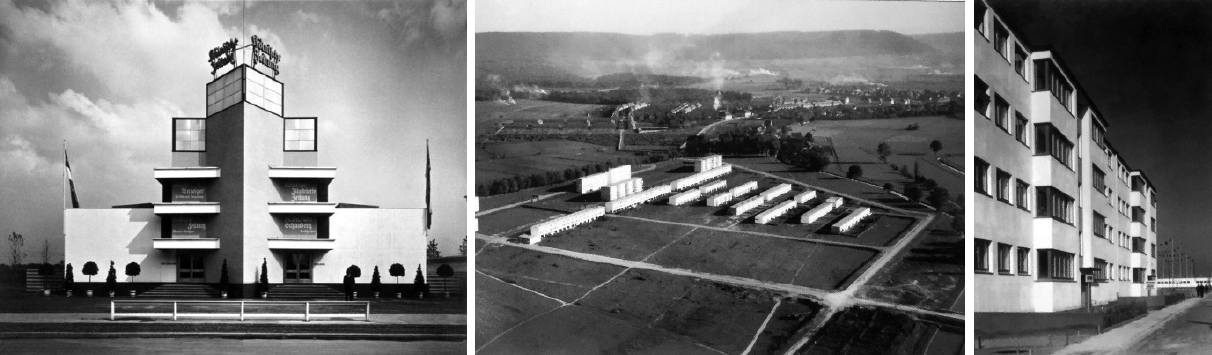
Figure 2. From left to right: W. Riphahn and C. M. Grod, Pavilion for the Kölnische Zeitung at the Pressa –International Press Exhibition Cologne, 1928 (Mantz, 1928); W. Riphahn and C. M. Grod, Dammerstock-Siedlung, aerial view from northwest, Karlsruhe, 1931 (Sträle, 1931); W. Riphahn and C. M. Grod, Dammerstock-Karlsruhe, eight family houses, oblique view, Karlsruhe, 1928 (Sander’s